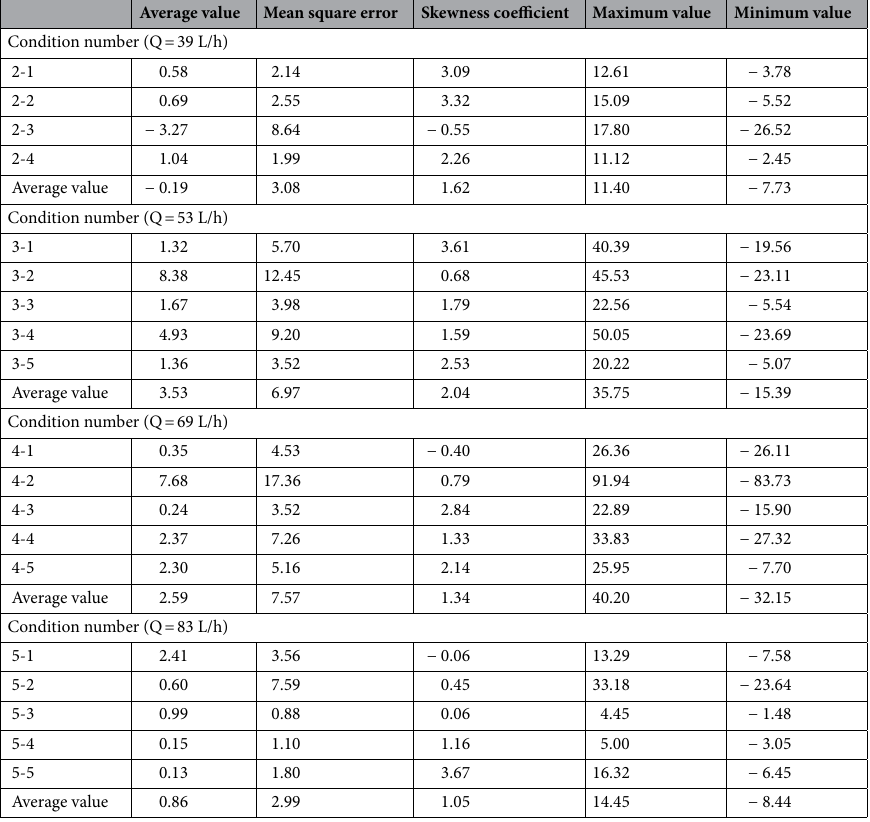
Table 2. Time domain statistical parameters of pebble vibration